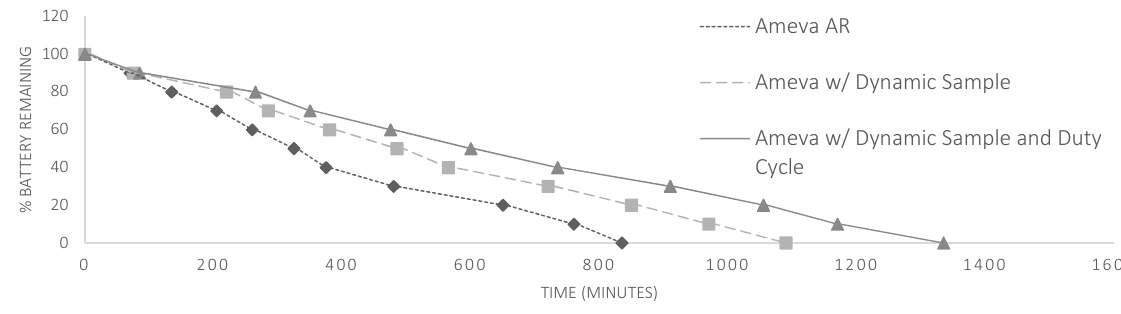
Figure 7. Comparison between simple Ameva method, Ameva with dynamic sample optimization and Ameva with the dynamic sample and duty